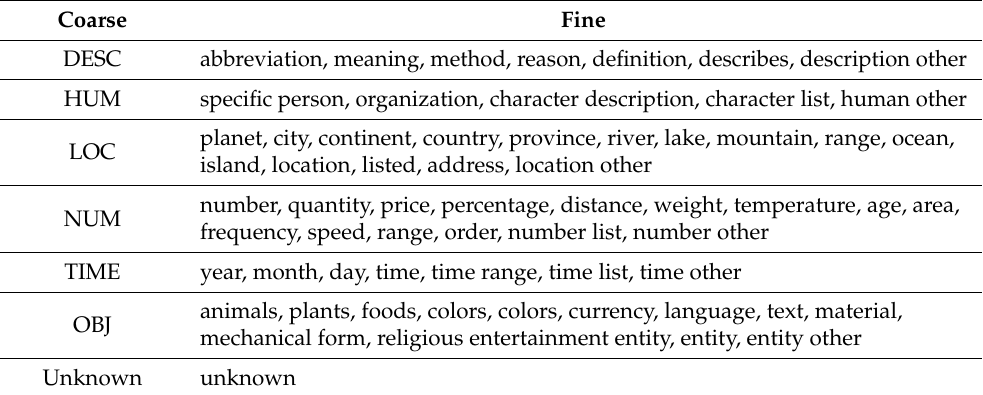
Table 2. Chinese classification